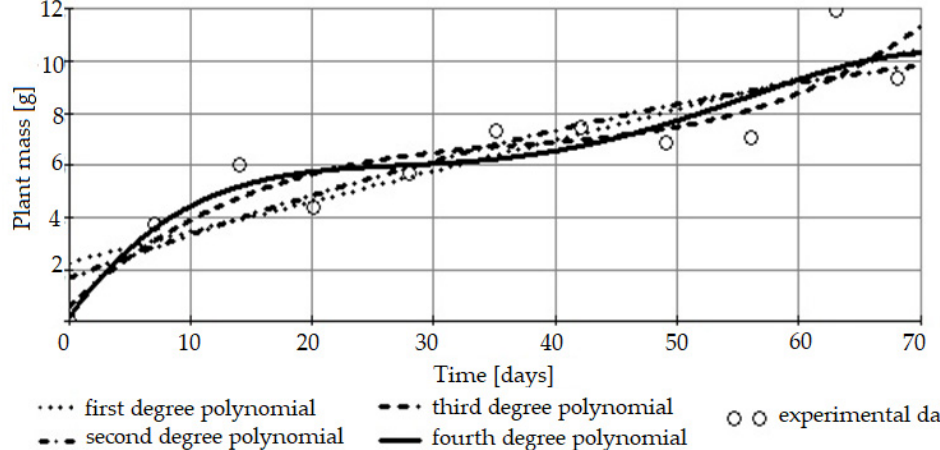
Figure 5. Time dependence of the mass of lettuces grown in soil contaminated with 4.5% zinc concentration, for 1 to 4degree polynomial interpolations.